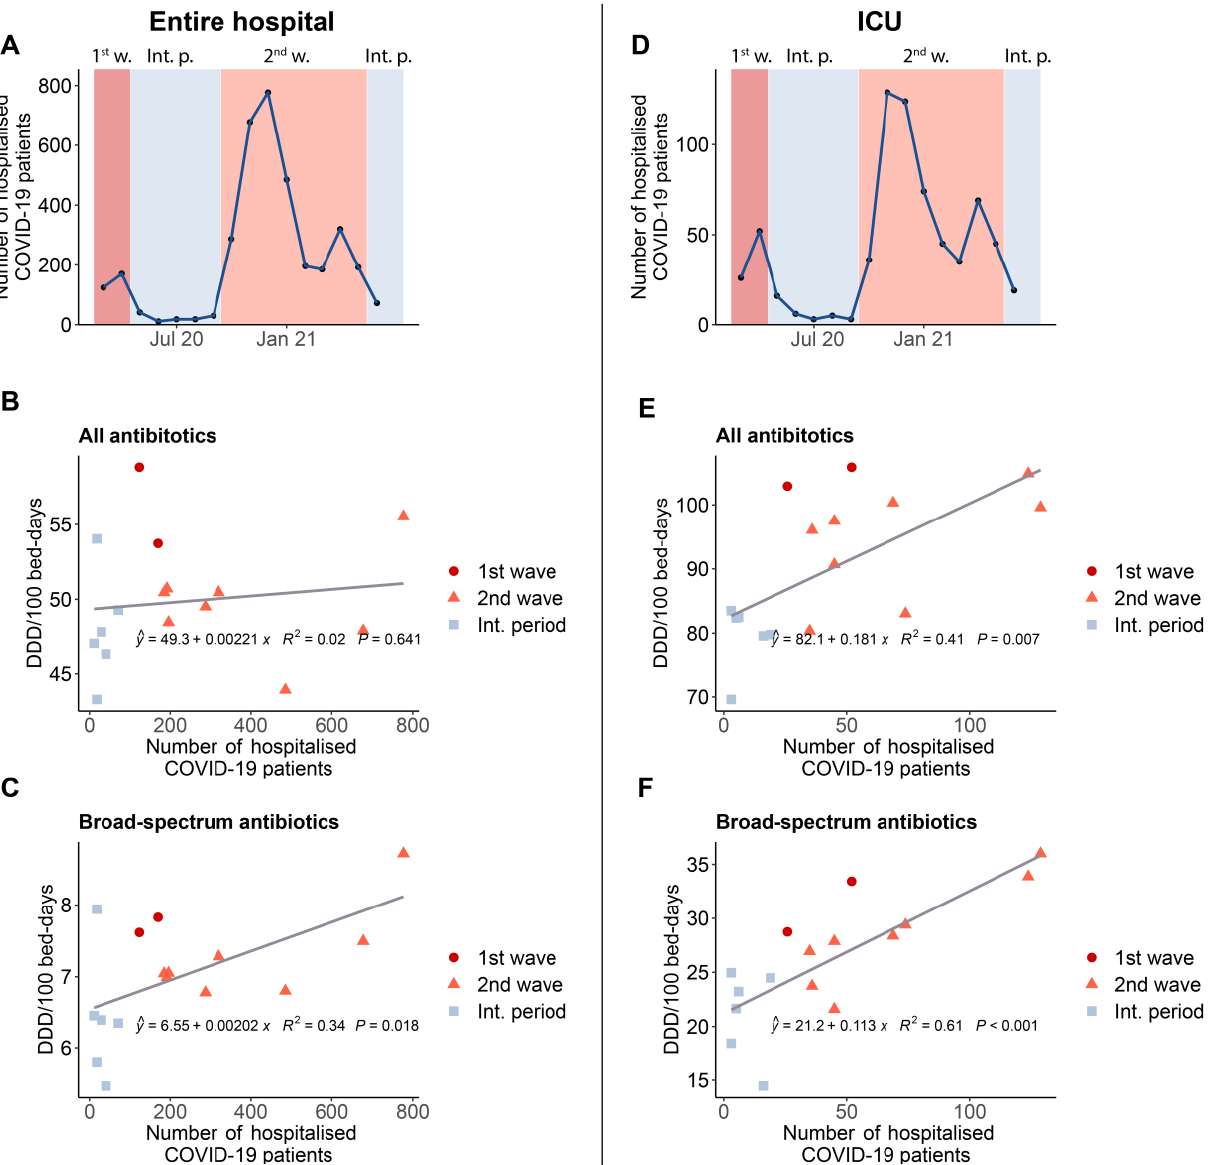
Figure 5. Correlation analysis for the entire hospital ( left side) and ICUs ( right side) based on aggregated data from four ANRESIS hospitals with available monthly antibiotic consumption and hospitalization data for COVID-19 patients. ( A , D ): Number of hospitalized patients with COVID- 19 per month ( B , E ): Correlation between the consumption of all systemic antibiotics in DDD per 100 bed-days and the number of hospitalized patients with COVID-19 ( C , F ): Correlation between consumption of broad-spectrum antibiotics in DDD per 100 bed-days and the number of hospitalized patients with COVID-19. ICU, intensive care unit; 1st w, 1st wave; Int. p., intermediate periods; 2nd w, 2nd wave.